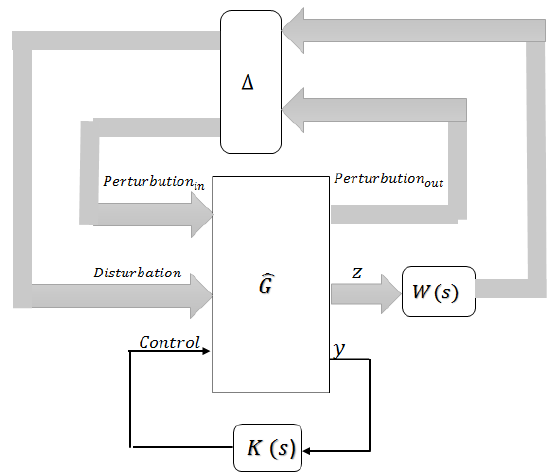
Figure 7. LFT framework of the proposed structure.